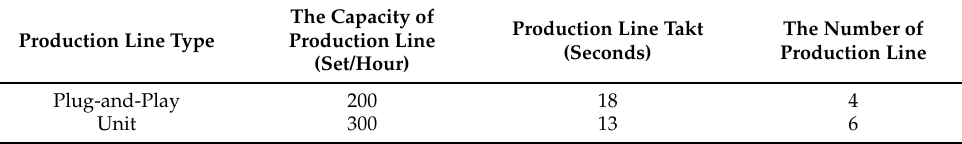
Table 6. Design Demand of Workshop Hybrid Production